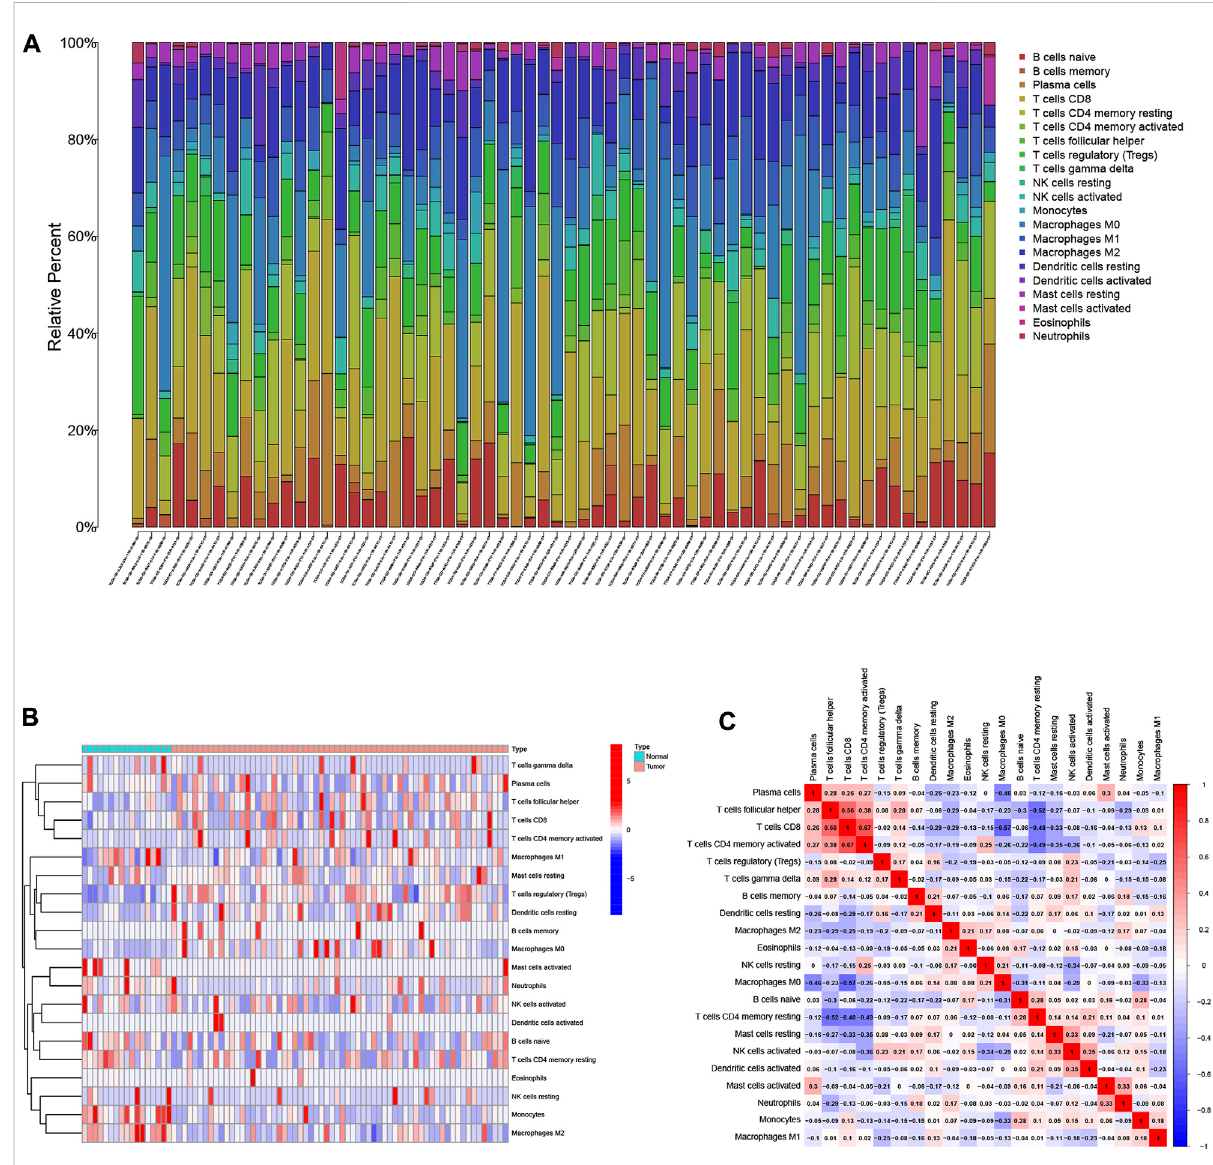
FIGURE 1 Landscape of immune cell in fi ltration in the tumor immune environment of HCC. Subpopulation of 22 immune cell subtypes (A) and proportional heatmap of 22 TICs in each HCC samples (B) . (C) Intrinsic correlation of 22 in fi ltrating immune cells in